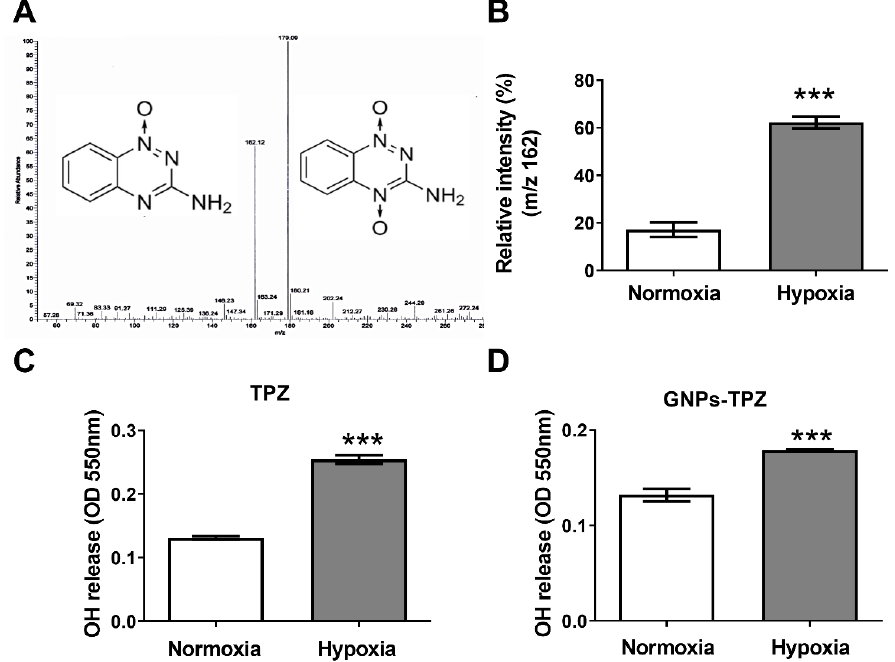
Figure 3. Increased hydroxyl radical ( • OH) released from TPZ under hypoxia condition.